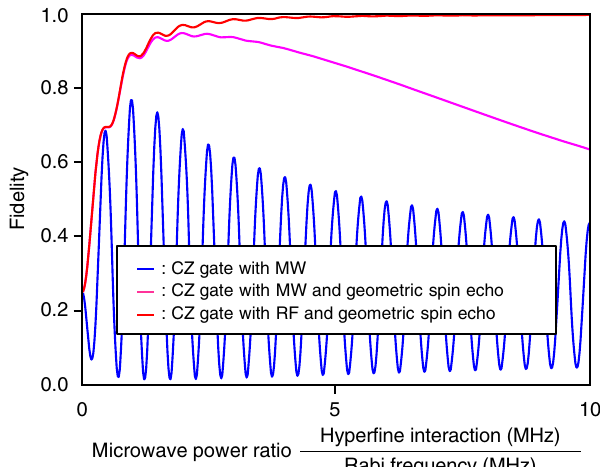
Fig. 10 Power dependence of CZ gate fi delity. Blue, pink, and red lines represent CZ gate fi delity with, respectively, the circularly polarised microwave, with the microwave and the geometric spin echo, and with the circularly polarised radiowave and the spin